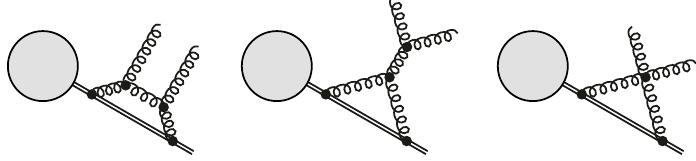
Figure 5 . Remaining diagrams with two soft-gluon emissions from a single Wilson line. Description as in figure